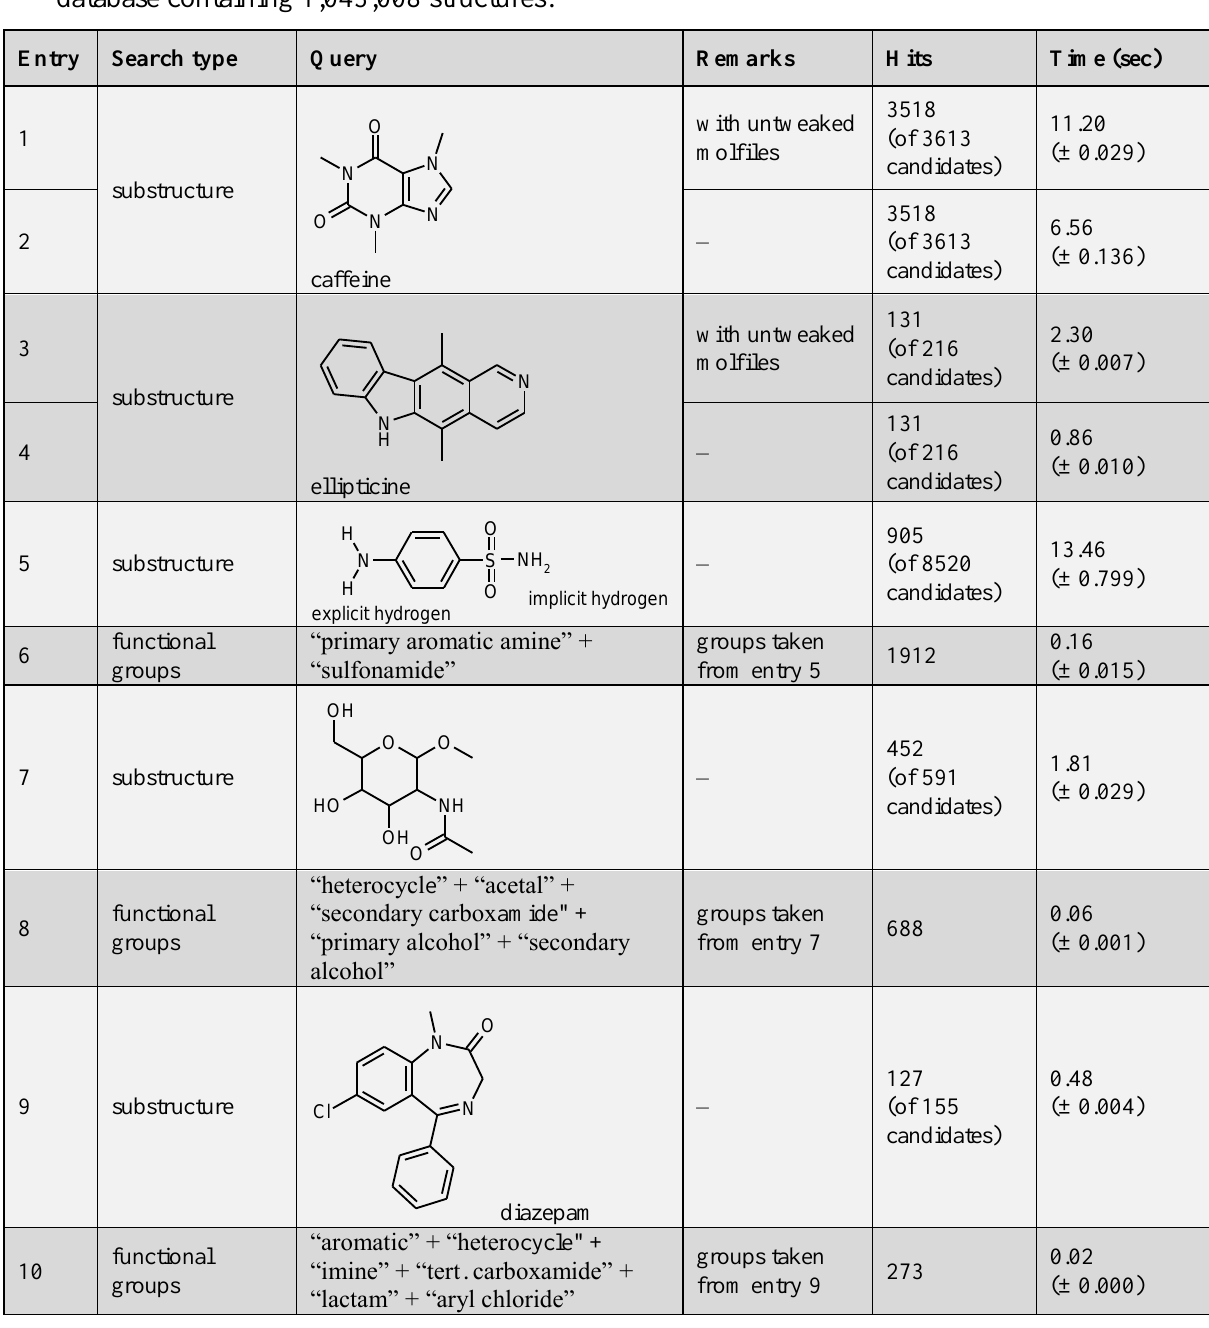
Table 1. Comparison of performance between different search types and options in a database containing 1,043,008